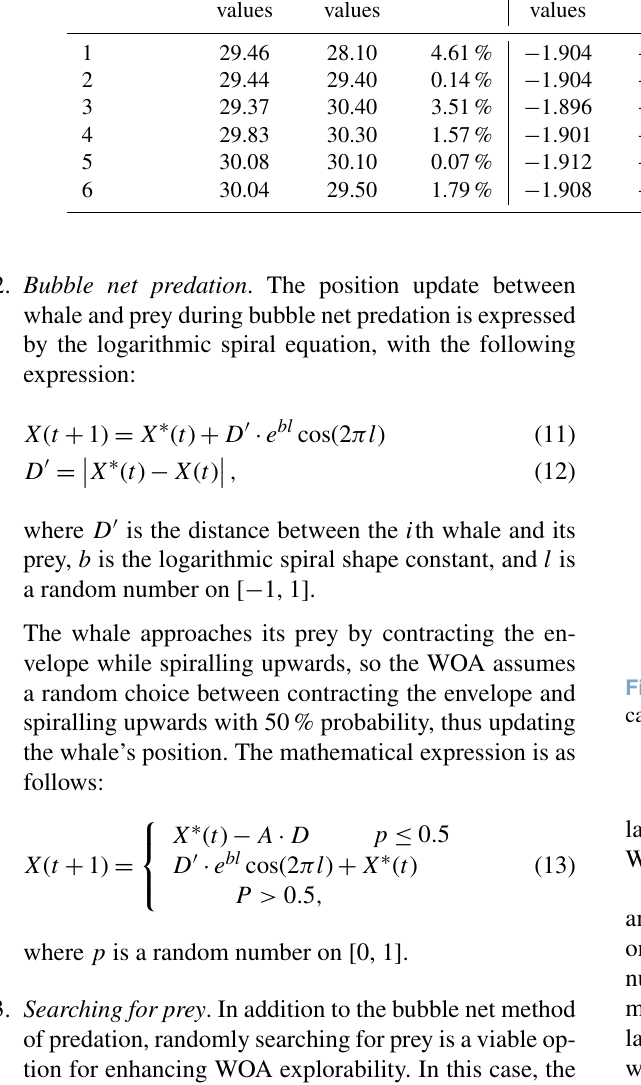
Table 6. Comparison of simulation results with fitted results. Programme V (ms − 1 ) P (KPa) η (%) Fitted Simulation Error Fitted Simulation Error Fitted Simulation Error values values values values values values